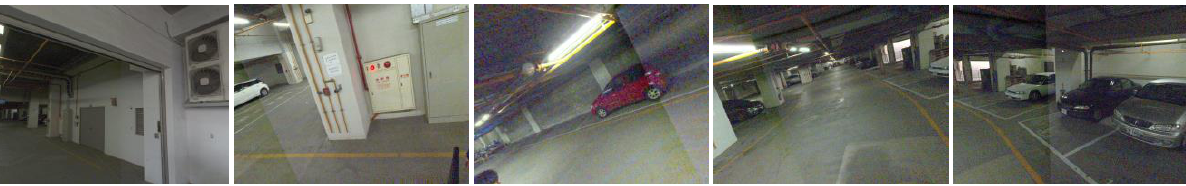
Figure 4. Sample images selected randomly from